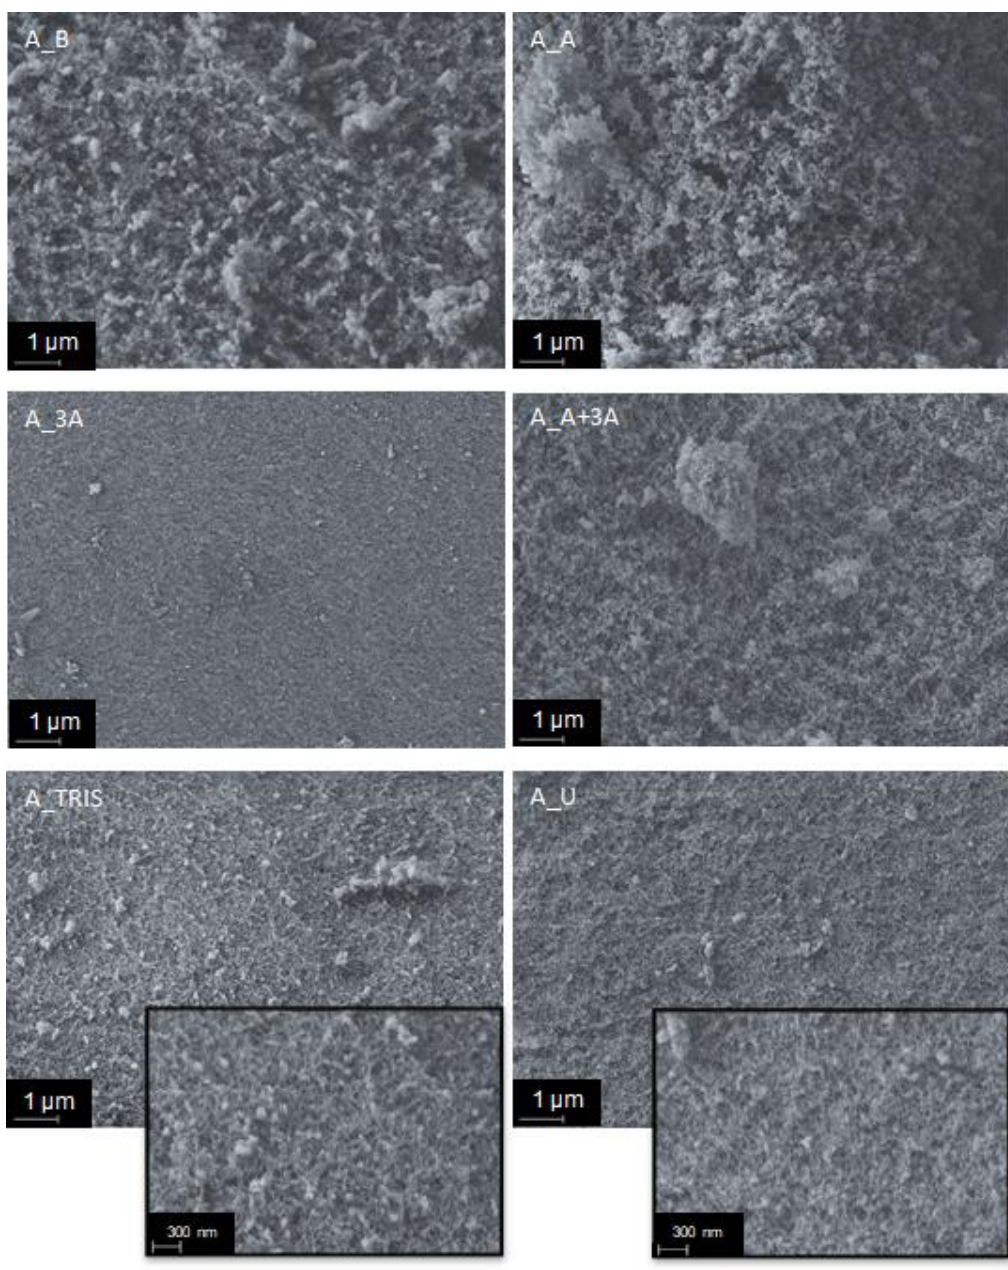
Figure 2. Morphology of the prepared aerogel samples (10,000 × magnification) and details for samples A_TRIS and A_U (30,000 × magnification).